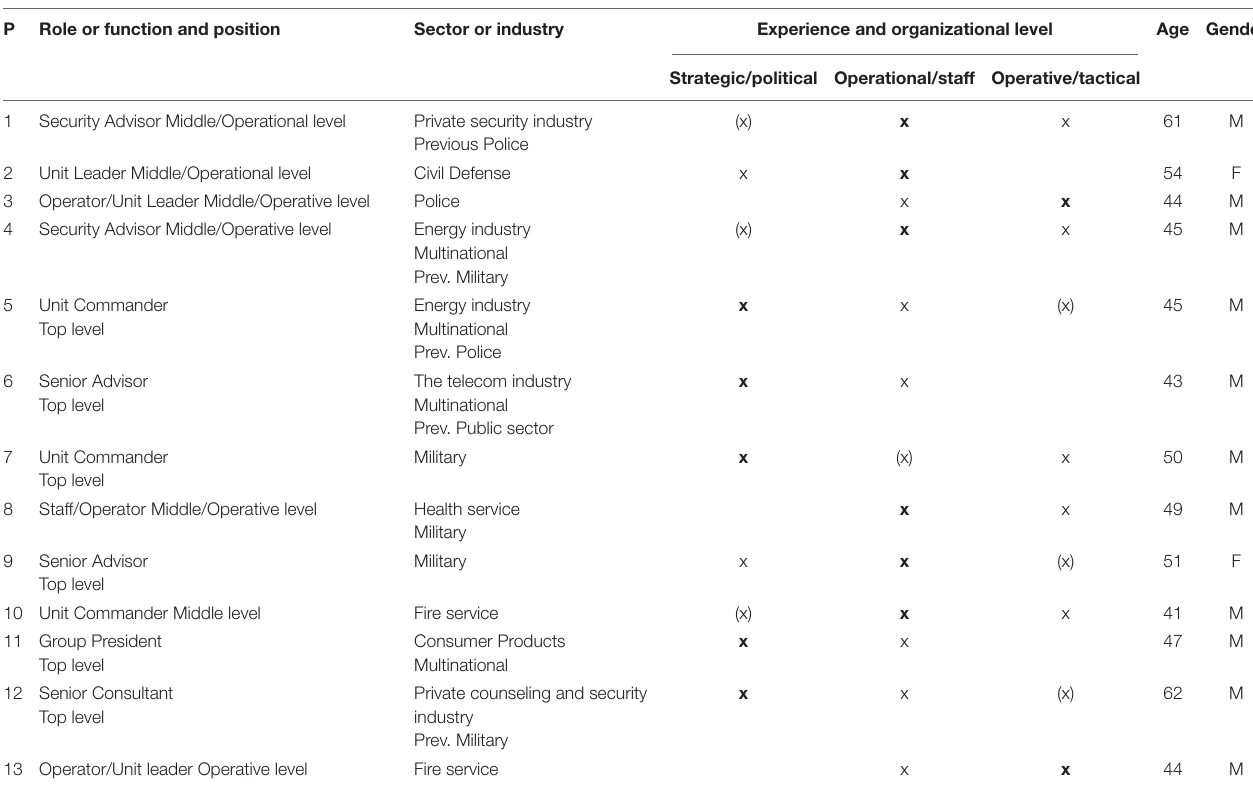
TABLE 1 | Matrix of study